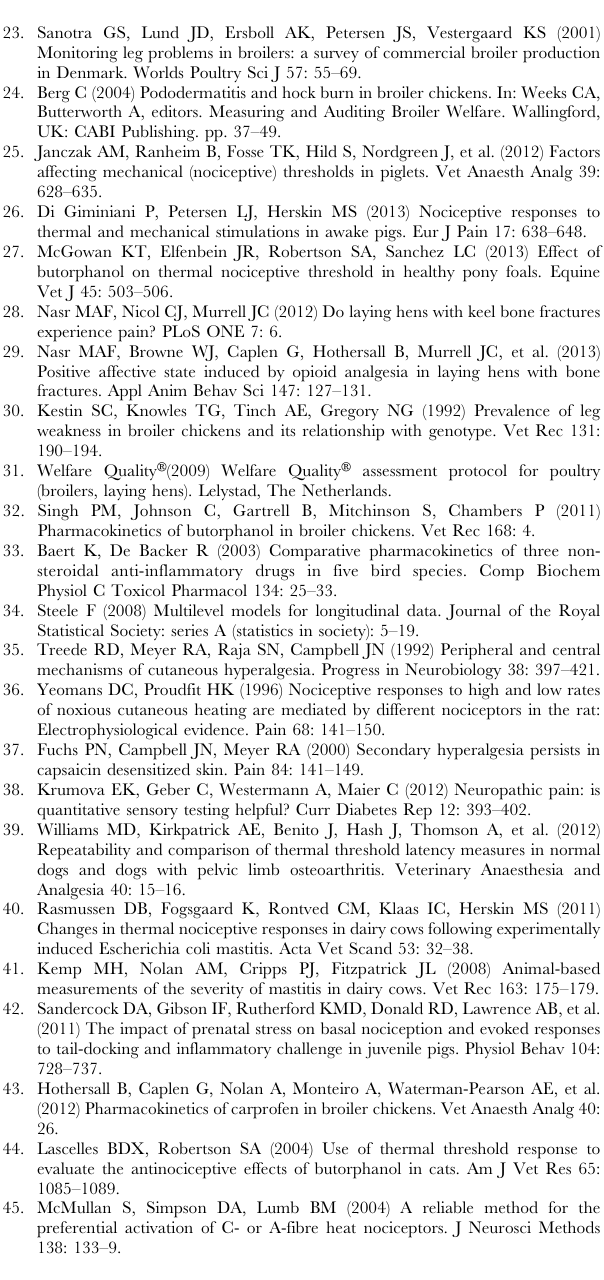
Table S2, Factors affecting thermal threshold in broilers. Table S3, Factors affecting skin temperature in broilers. Table S4, Factors affecting thermal nociceptive threshold in broilers administered saline or meloxicam. Table S5, Factors affecting skin temperature in broilers administered saline or meloxicam. Table S6, Factors affecting thermal nociceptive threshold in broilers administered saline or